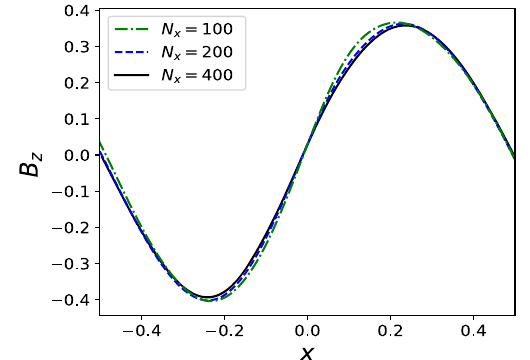
Fig. 5 The magnetic field component B y at t = 9 in the self-similar current sheet test, with the initial condition at t = 1 lines stand for the numerical result of B y and the